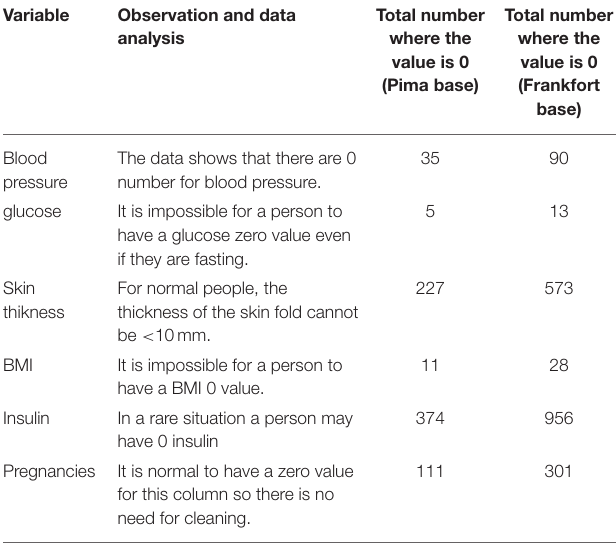
TABLE 1 | The observation and analysis of the two databases.